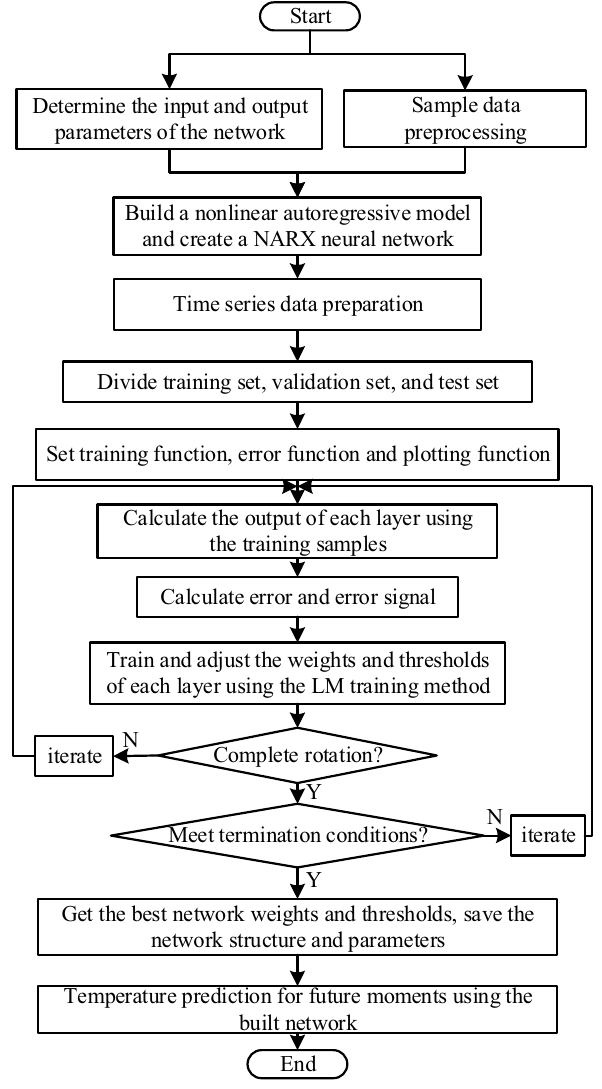
Figure 3. Specific flowchart of the NARXNN